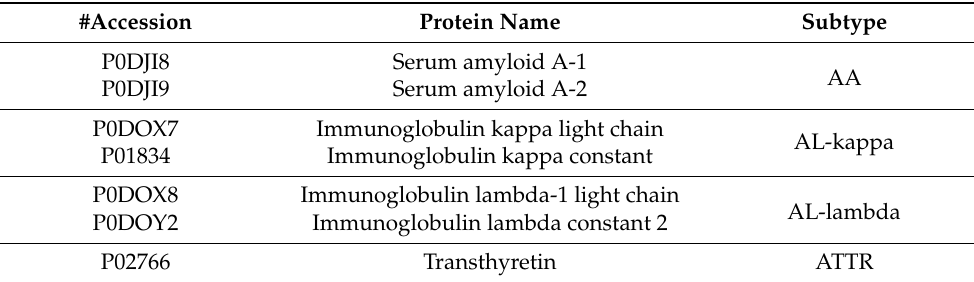
Table 4. Subtype-specific proteins included in subtype classification model. These proteins are commonly observed in high levels in relation to their respective subtype and were, therefore, selected for the